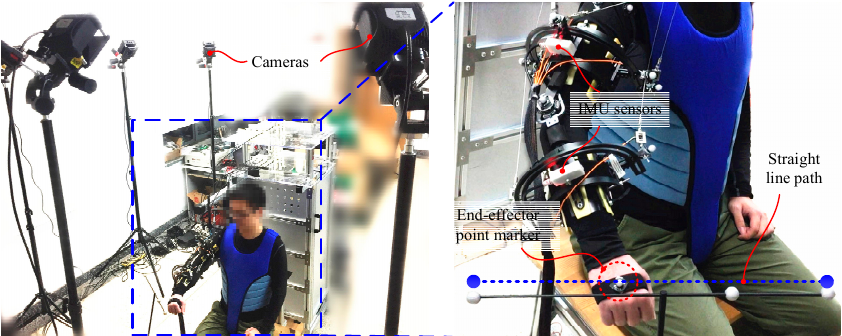
Figure 6. Experimental setup described as a subject tracks a line path. The motion of the subject’s upper limb is characterized by both IMU sensors placed on the exoskeleton and a motion capture